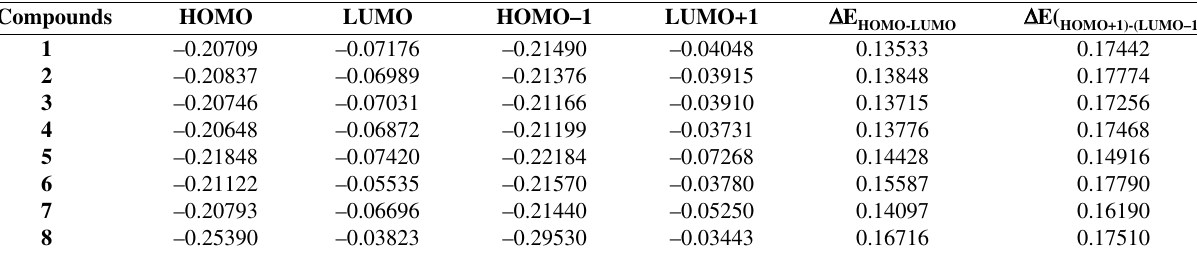
Table 2. Calculations of HOMO-LUMO energies for compounds ((1–8)) Compounds